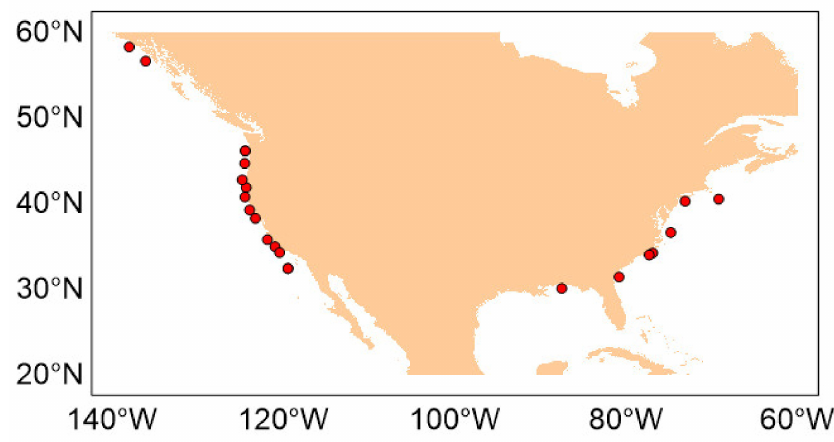
Figure 4. NDBC buoy